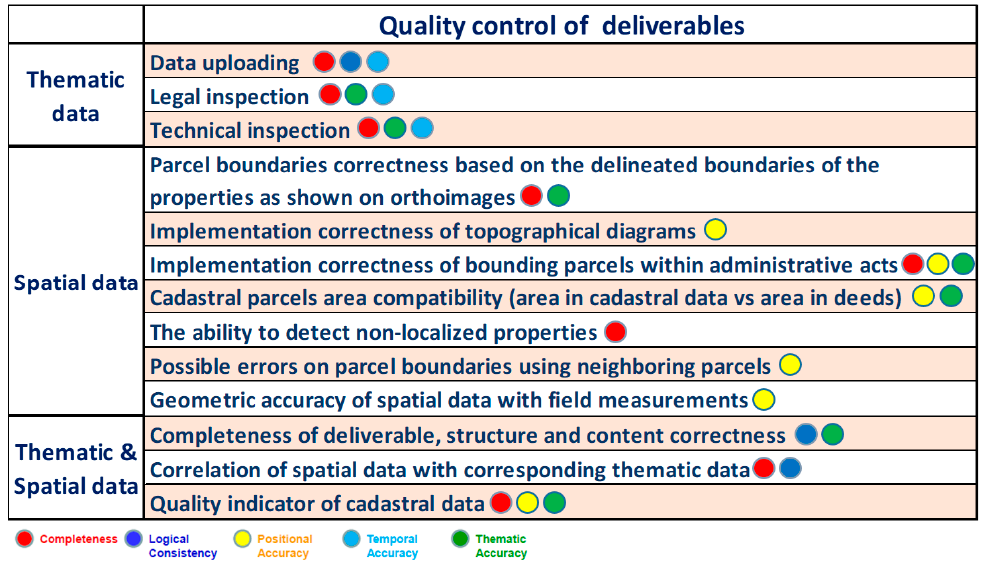
Figure 16. QC of deliverables. Source: [36].